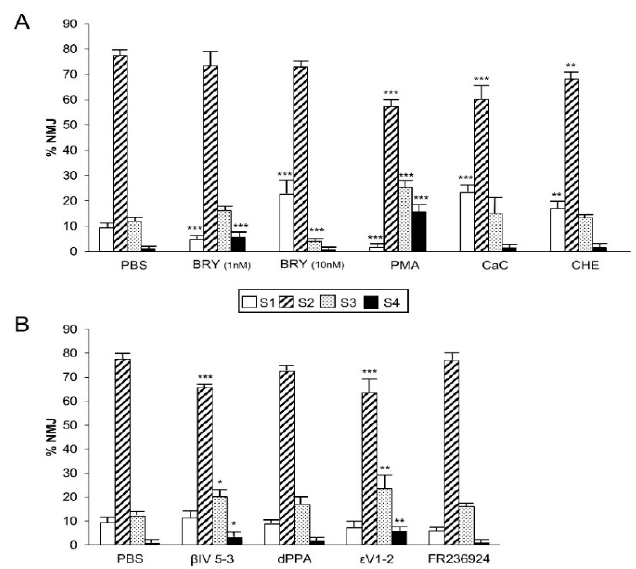
Figure 6. Diagrammatic representation of PKC involvement in synapse maturation. ( A ) shows the e ff ect on axonal retraction and nAChR cluster maturation of the unselective PKC inhibitors and PKC Figure 5. Stimulation and inhibition of PKC modifies the postsynaptic receptor cluster during stimulators. ( B ) shows the e ff ect of the nPKC ε and cPKC β I postnatal maturation. The histogram in ( A ) shows that the unselective stimulation and inhibition of PKC affects the maturation of the postsynaptic nAChR clusters. Inhibition with CHE or with CaC results in the persistence of the immature S1 clusters. Accordingly, PMA (10 nM) accelerates postsynaptic maturation and a similar effect is observed with BRY (1 nM). However, 10 nM BRY downregulates the PKC at the postsynaptic site. ( B ) shows that the specific stimulation and inhibition of cPKC β I and nPKC ε isoforms affects the maturation of the nAChR clusters. Blocking these kinases accelerates postsynaptic maturation though the selective stimulation with dPPA and FR 236,924 respectively show no influence on the maturation of the nAChR clusters. Data were presented as mean ± SD (for each treatment and PBS control: n pups = 6; n = 12 LALs). Fisher’s test: * p < 0.05, ** p < 0.01, *** p < 0.005.